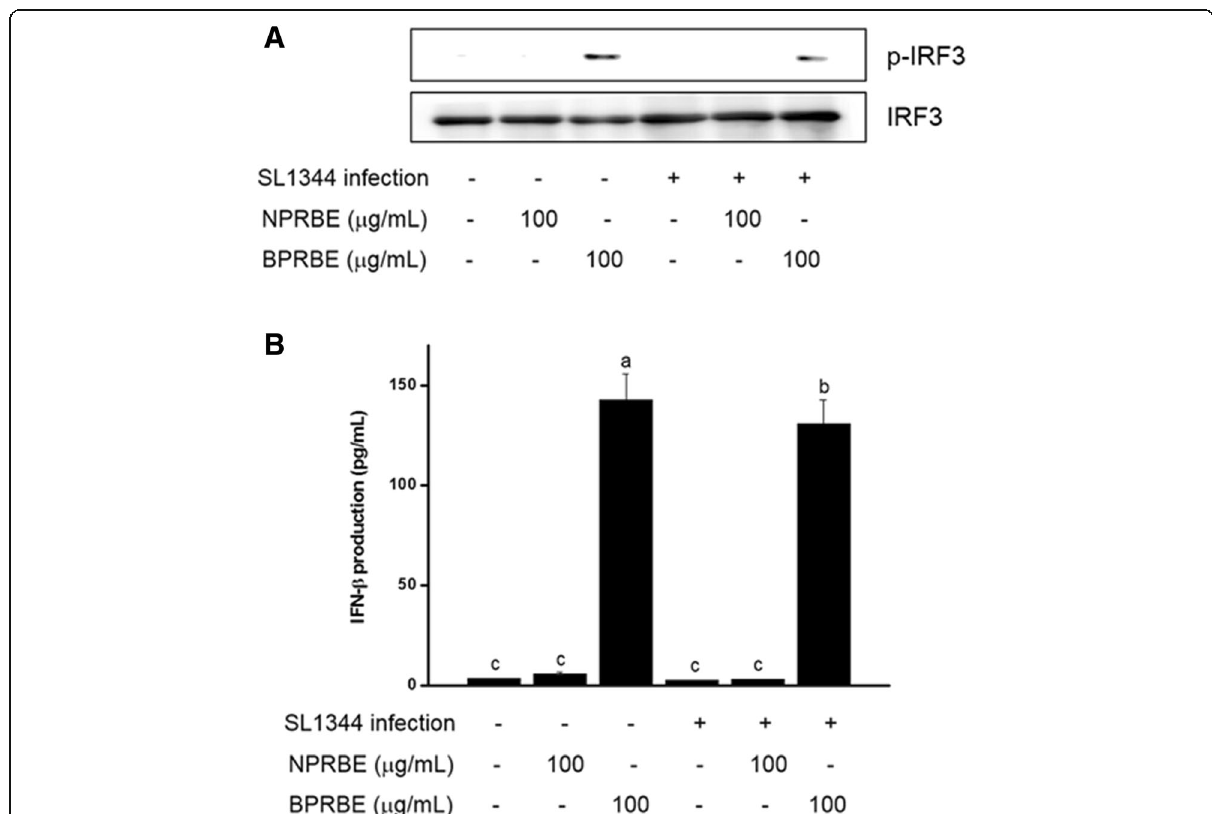
Fig. 5 Effects of BPRBE on induction of IFN- β production through IRF3 activation in S. Typhimurium-infected macrophages. a Phospho-IRF3 protein (p-IRF3) expression profiles assessed by Western blot analysis. RAW 264.7 cells (1 × 10 5 ) were treated with BPRBE and NPRBE for 24 h and infected with S. Typhimurium and lysed. The phospho-form of IRF3 in the cell lysates was identified using Western blotting. b IFN- β release from S. Typhimurium-infected macrophages pre-treated with BPRBE and NPRBE was determined using an ELISA kit. Data are expressed as the mean ± SD of triplicate experiments. Bars sharing a common letter are not significantly different at p < 0.05